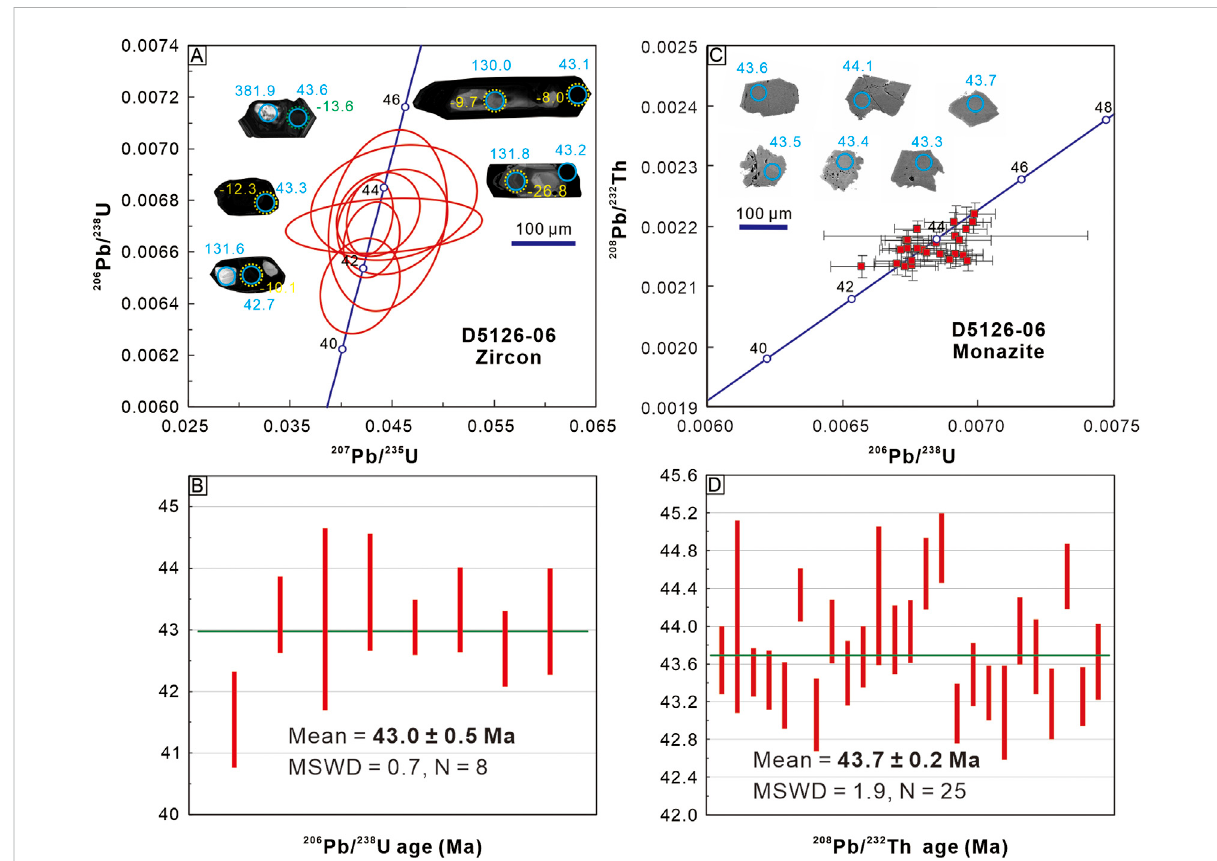
FIGURE 4 (A) U-Pb concordia diagramof zircons and cathodoluminescence images ofrepresentativezirconswith corresponding 206 Pb/ 238 U ages and ε Hf (t)valuesand (B) theweightedmeanageforzirconsoftheLiemaitwo-micagranite; (C) U-Th-PbconcordiadiagramofmonazitesandBSEimagesof representative monazites with corresponding 208 Pb/ 232 Th ages and (D) the weighted mean age for monazites of the Liemai two-mica